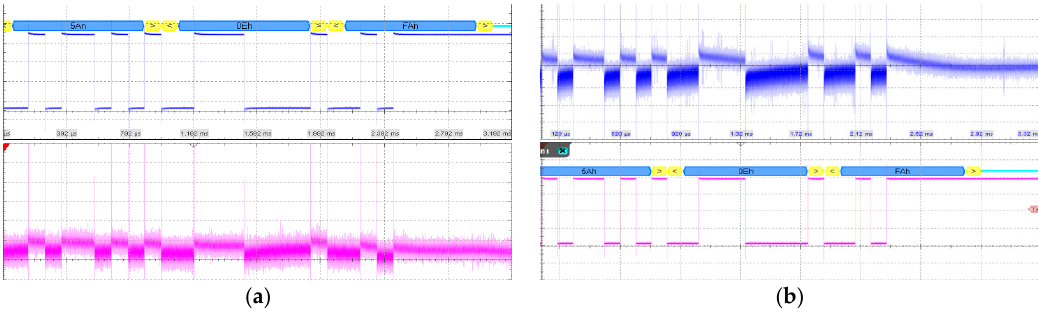
Figure 17. Communication waveforms on the transmitter and receiver sides after amplification. ( a ) On the transmitter side; ( b ) On the receiver side.